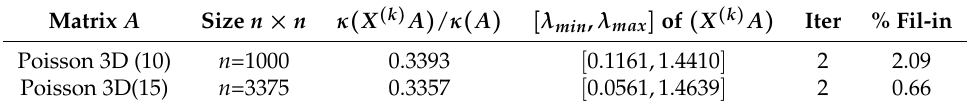
Table 6. Performance of MinCos applied to the Poisson 3D matrix, for different values of n and a maximum of 20 iterations, when (cid:101) = 0.01, thr = 0.01, and l fil = 40.